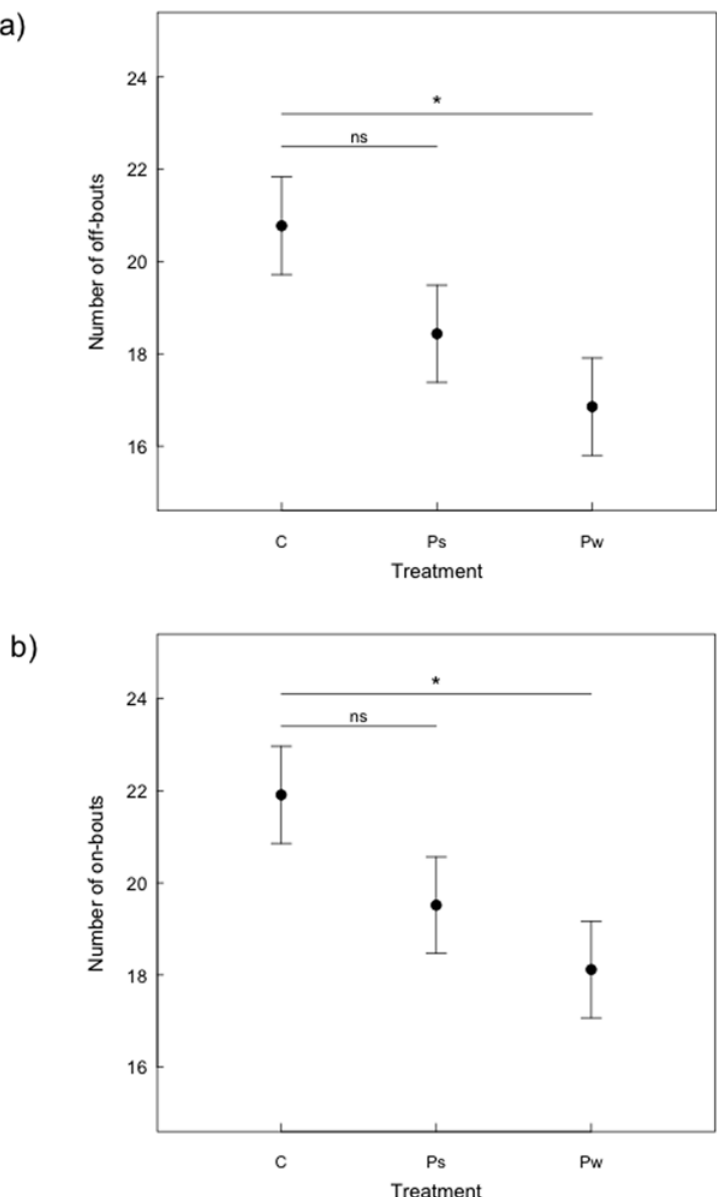
Fig 2. Average number of on-and off-bouts (mean ± SE) from a GLMM with Poisson error structure. (a) Females incubating in increased nest predation risk environments (Pw) had a lower number of off-bouts/ active day compared to the control. Females under an increased post-fledging predator risk (Ps) had a tendency for a lower number of off-bouts compared to the control ( P = 0.008). (b) Females incubating in increased nest predation risk environments (Pw) had a significantly lower number of on-bouts/active day compared to the control. Females under an increased post-fledging predator risk (Ps) had a slightly but non significantly lower number of on-bouts compared to the control ( P =